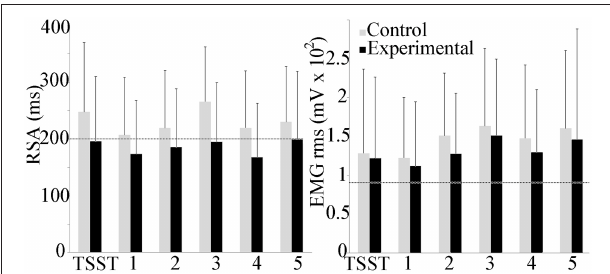
FIGURE 5 | Group differences in respiratory sinus arrhythmia (RSA) and trapezius muscle activity during the experiment. Average baseline scores shown by dotted line. No group or scenario differences were